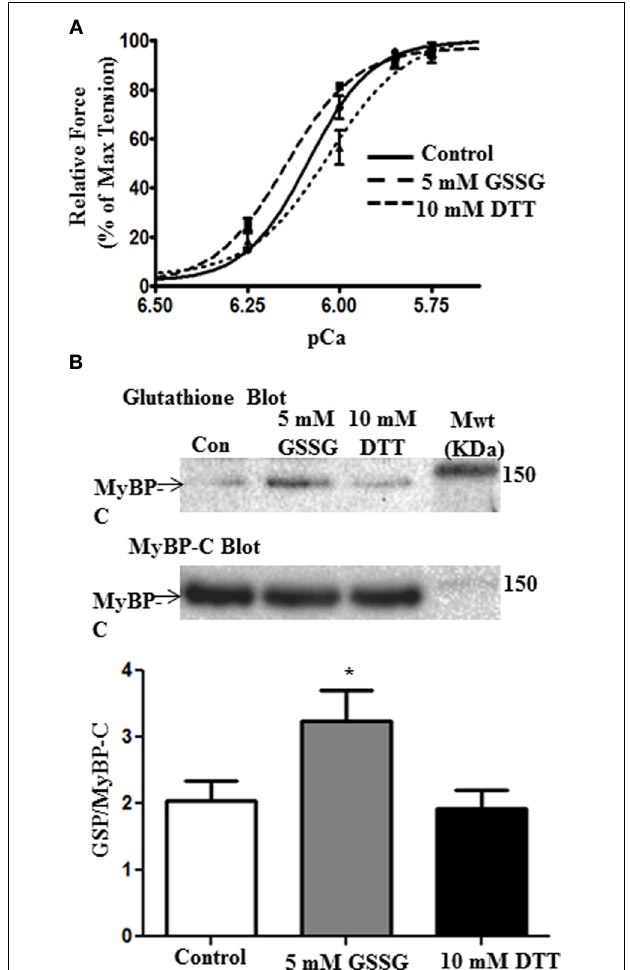
FIGURE 3 | The effects of GSSG and DTT on force generating parameters of skinned papillary fibers. (A) Data represent the force-pCa relationship in skinned cardiac muscle fibers recorded primarily using only the varying increasing Ca 2 + solutions, then followed by treatment with 5mM GSSG in A-70 for 10min and subsequently bathed in the Ca 2 + solutions. The fibers were then incubated in 10mM DTT in A-70 for 10min and were then bathed in increasing Ca 2 + solutions again. The pCa50 values were all statistically significant between treatments. pCa50 values for control fibers, 5mM GSSG treatment, and 10mM DTT treatment were 6.09 ± 0.01, 6.15 ± 0.01, and 6.03 ± 0.02, respectively. Data represented as mean ± SEM, n = 4 for all groups, significance was set at p < 0 . 05. ( n H , minimum pCa, and maximum pCa values were not significant). (B) Western blot analysis of skinned fiber showing significant difference in glutathionylation levels between control and GSSG treated fibers ( p = 0 . 05). Glutathionylation levels are also significantly decreased when fibers were treated with DTT compared to the GSSG treated fibers ( p = 0 . 03). There is no significant difference between control and DTT treatment. Data are expressed as mean ± standard error of mean, n = 6 . 7 ( ∗ P ≤